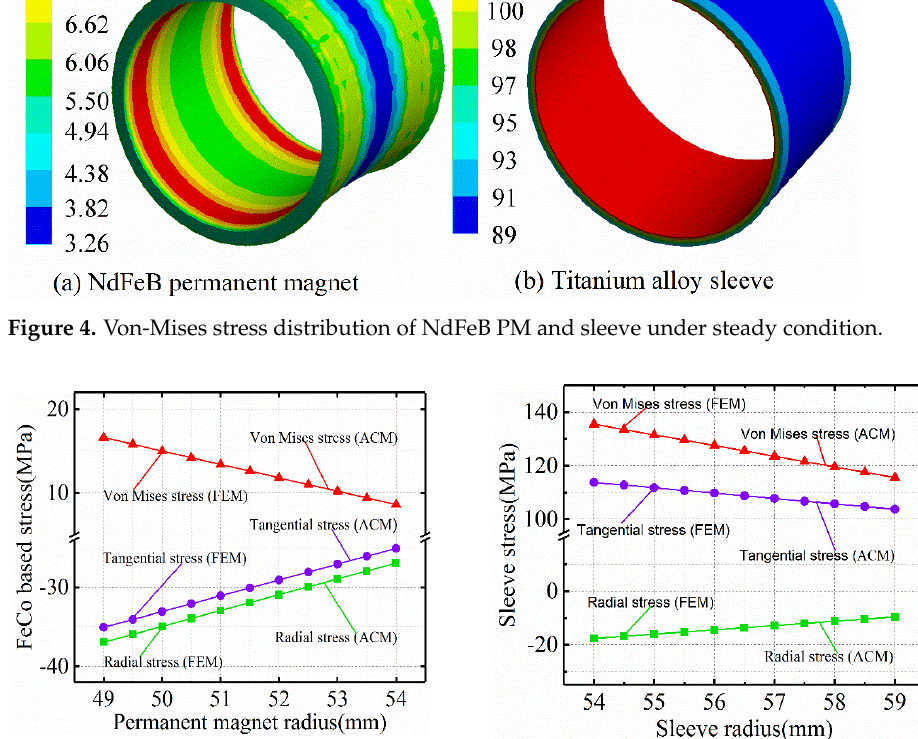
Figure 4. Von-Mises stress distribution of NdFeB PM and sleeve under steady condition.